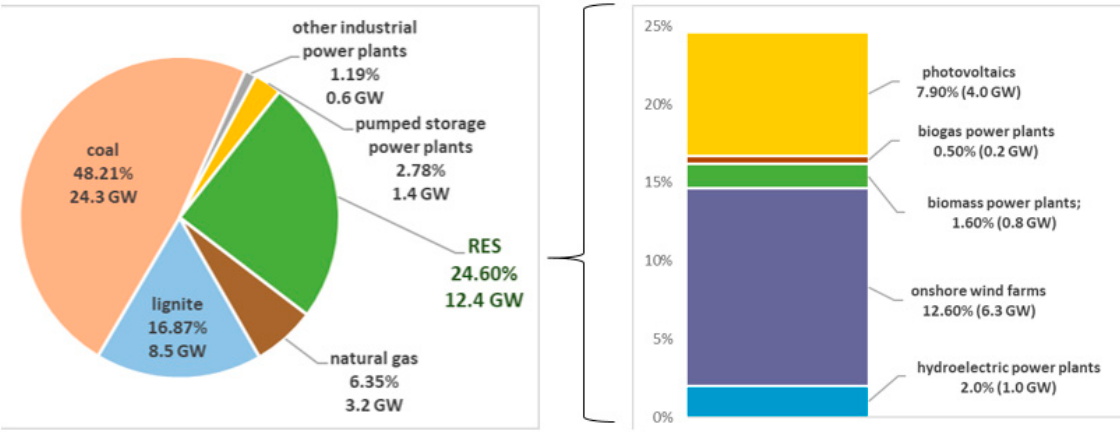
Figure 3. Generation capacity in Poland in 2020 (in GW).